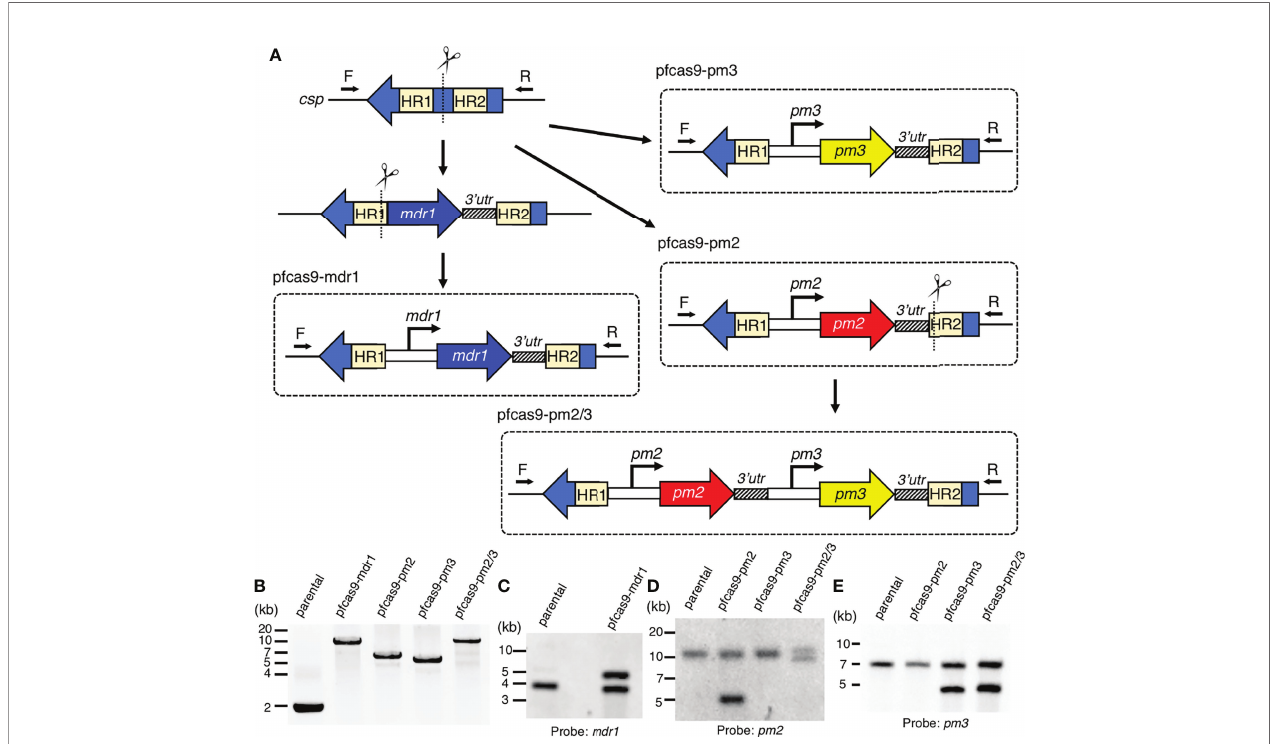
FIGURE 1 | Generation of transgenic parasites with an additional copy of drug resistance-associated genes by CRISPR/Cas9-based genome editing. (A) Schematic representation of a strategy to derive transgenic parasites with an additional copy of drug resistance-associated genes. The pfcas9 parasite line was transfected with an sgRNA expression vector and a linear form of the donor DNA template. The drug resistance-associated gene expression cassette was integrated into the csp locus via homology-directed repair. (B) Genotyping PCR was performed using csp-check-F and csp-check-R primers. For each transgenic parasite, the integration of an additional copy into the csp locus was con fi rmed. (C – E) Southern hybridization analyses of transgenic parasites were carried out using partial DNA fragments of mdr1 (C) , pm2 (D) , and pm3 (E) open reading frames as the DNA probes. A double signal indicating gene ampli fi cation was detected in each transgenic